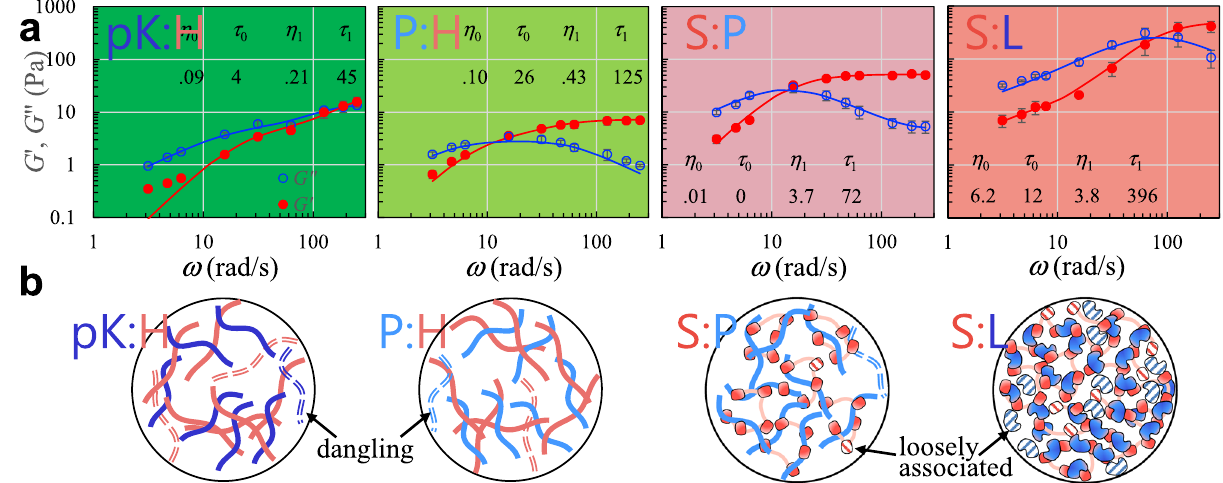
Fig. 3 Complex shear moduli and macromolecular networks of four types of droplets. a Elastic ( G ′ ; red fi lled circles) and viscous ( G ″ ; blue open circles) moduli of pK:H, P:H, S:P, and S:L droplets. Data were presented as mean ± standard error of the mean ( N = 3 or 4 replicate measurements). The trap stiffnesses were 310 pN/ μ m for pK:H, P:H, and S:P droplets and 1850 pN/ μ m for S:L droplets. Fits of the data to the Burgers model (Eq. 2a, b) are shown as red and blue curves. The fi tting parameters ( η in Pa s and τ in ms) are listed in the fi gures. b Illustration of macromolecular networks inside droplets. Dangling polymer chains are shown as a dash; loosely associated domains are shown as hatched fi ll. Successive increases in macromolecular packing density from pK:H and P:H to S:P and to S:L are supported by thio fl avin T fl uorescence intensity observed on a confocal microscope 26 both at R = 3 μ m, are compared for each type of droplets in Fig. 4c and in Table 1. The percentage differences between and predicted τ N are 3.4, 18, 24, and 104%, measured τ fu fu respectively, for pK:H, P:H, S:P, and S:L. The viscocapillary model overpredicts fusion times for the fi rst two types of droplets but underpredicts them for the last two types of droplets. The opposite directions of the discrepancies for the fi rst and last members of the series account for the much narrower range of the predicted fusion times.